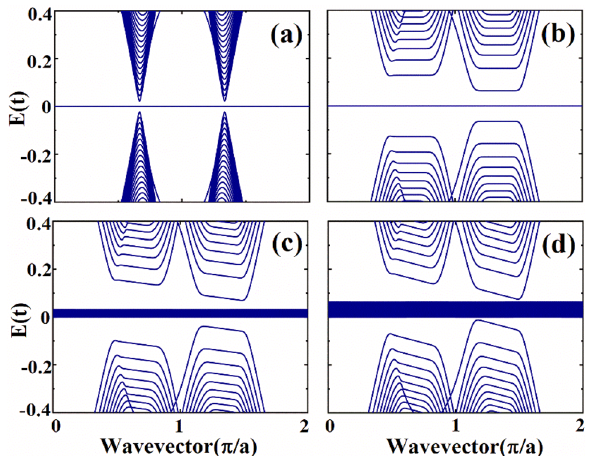
Figure 2. Band structures of zigzag ribbons with various magnetic flux φ and electric field eE y . ( a ) φ = 0 and eE y = 0 . ( b ) φ = 0.0015 and eE y = 0 . ( c ) φ = 0.0015 and eE y = 0.001 t /nm . ( d ) φ = 0.0015 and eE y = 0.002 t /nm